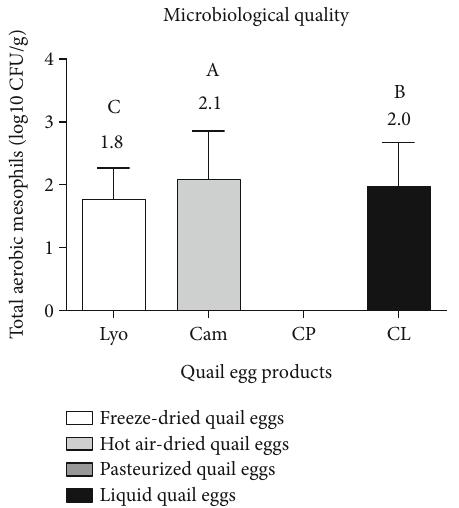
Figure 8: Microbiological quality of liquid (CL), freeze-dried (Lyo), hot air-dried (Cam), and pasteurized (CP) quail